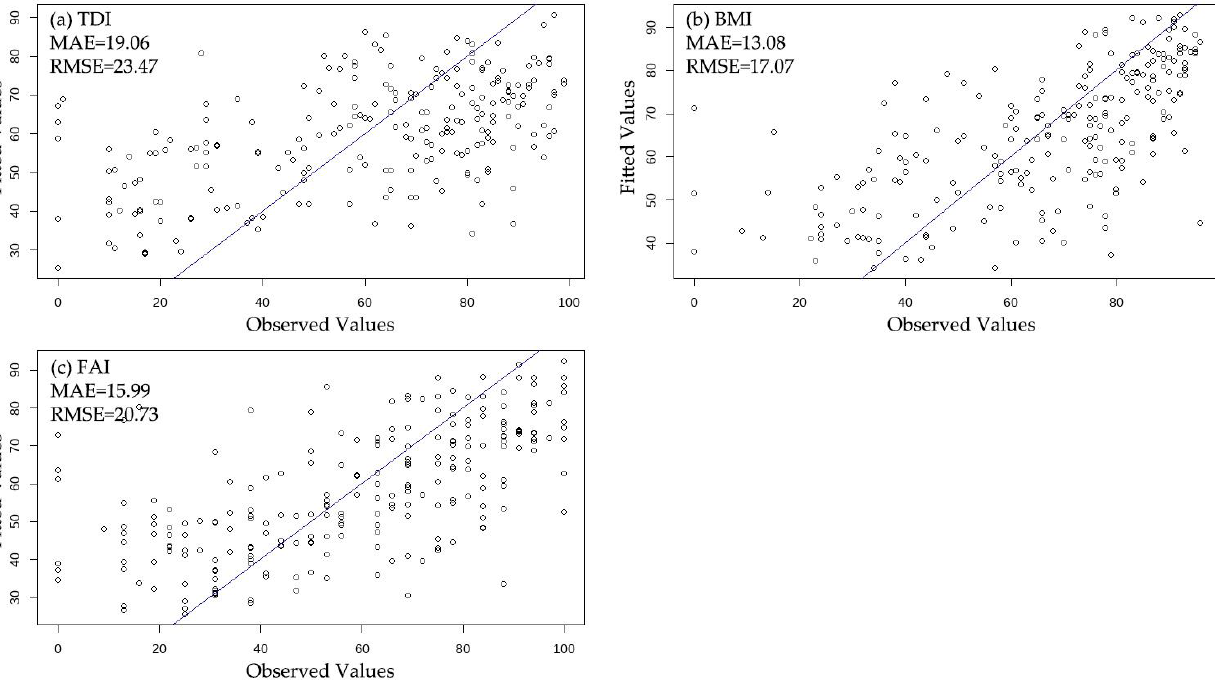
Figure 2. Comparison of random forest model performances for the estimation of biological indicators: ( a ) Trophic Diatom Index (TDI); ( b ) Benthic Macroinvertebrate Index (BMI); and ( c ) Fish Assessment Index (FAI). MAE, mean absolute error; RMSE, root mean square